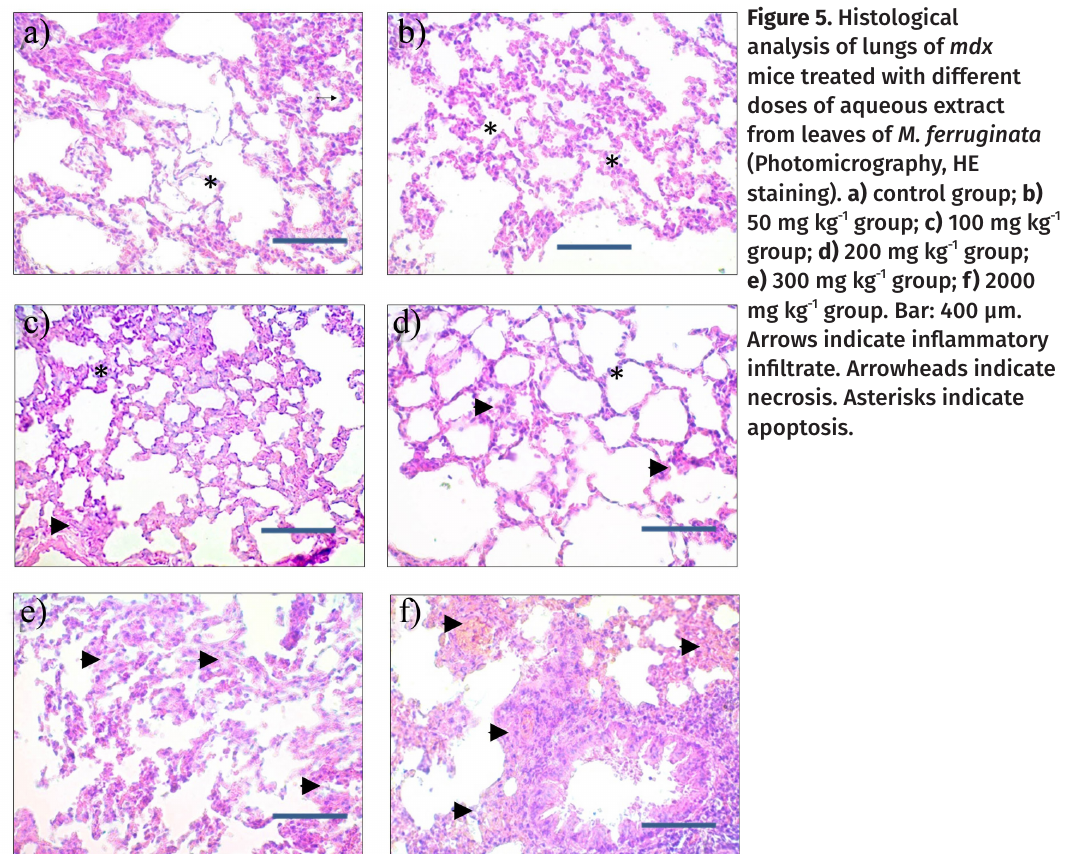
Arrows indicate inflammatory infiltrate. Arrowheads indicate necrosis. Asterisks indicate